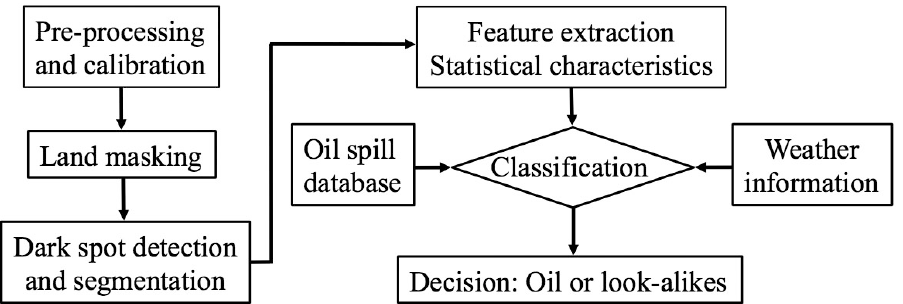
Figure 17. General procedure for oil slick detection